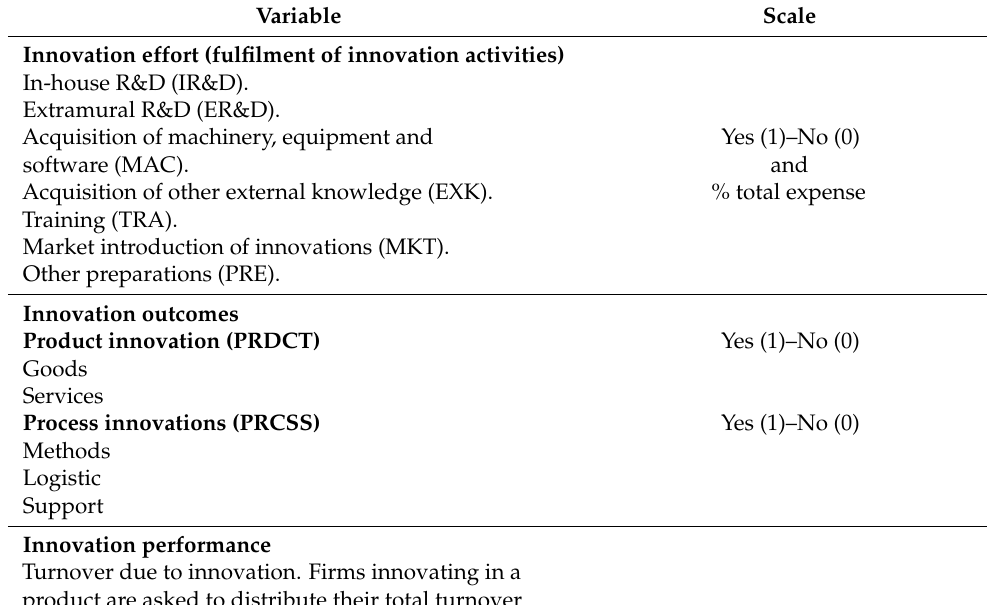
Table 4. Variables and